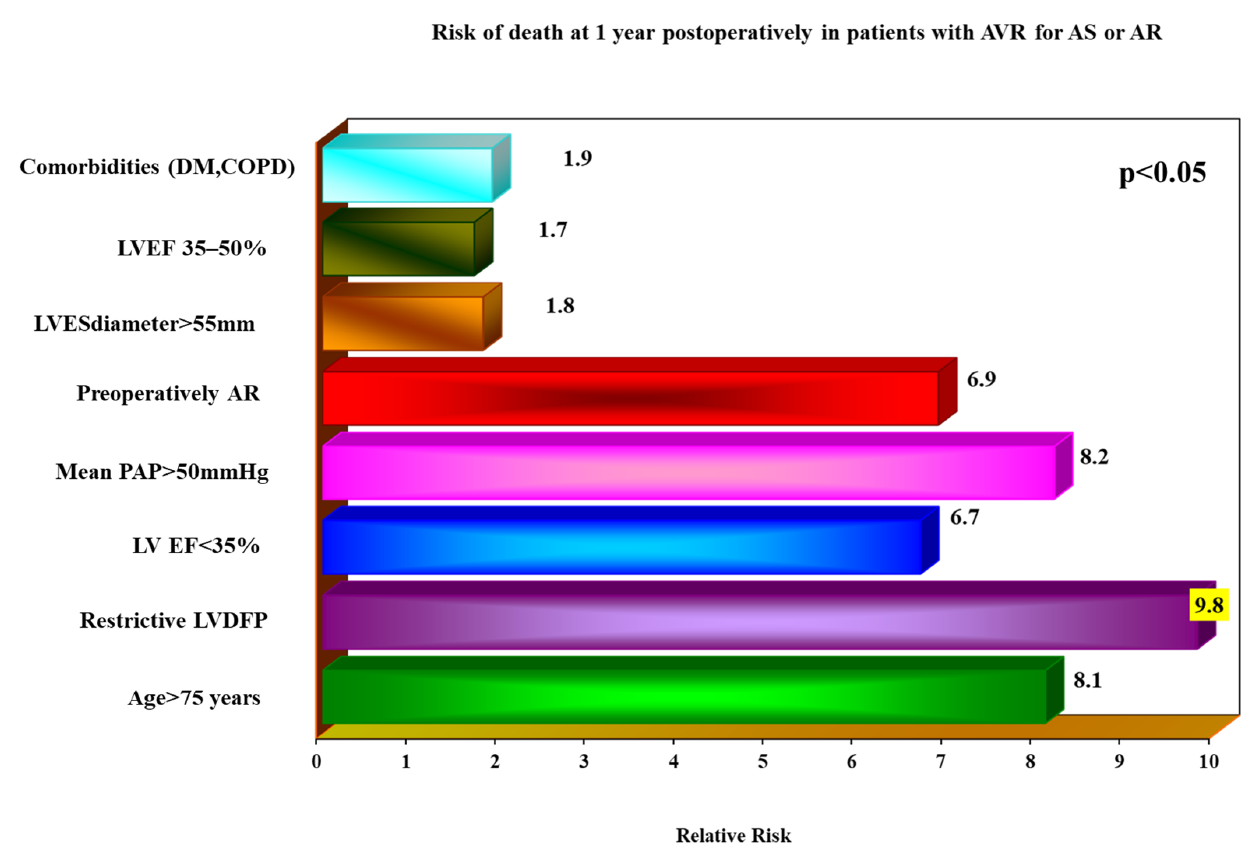
Figure 2. Risk of death at 1 year postoperatively in patients with AVR for AS or AR.